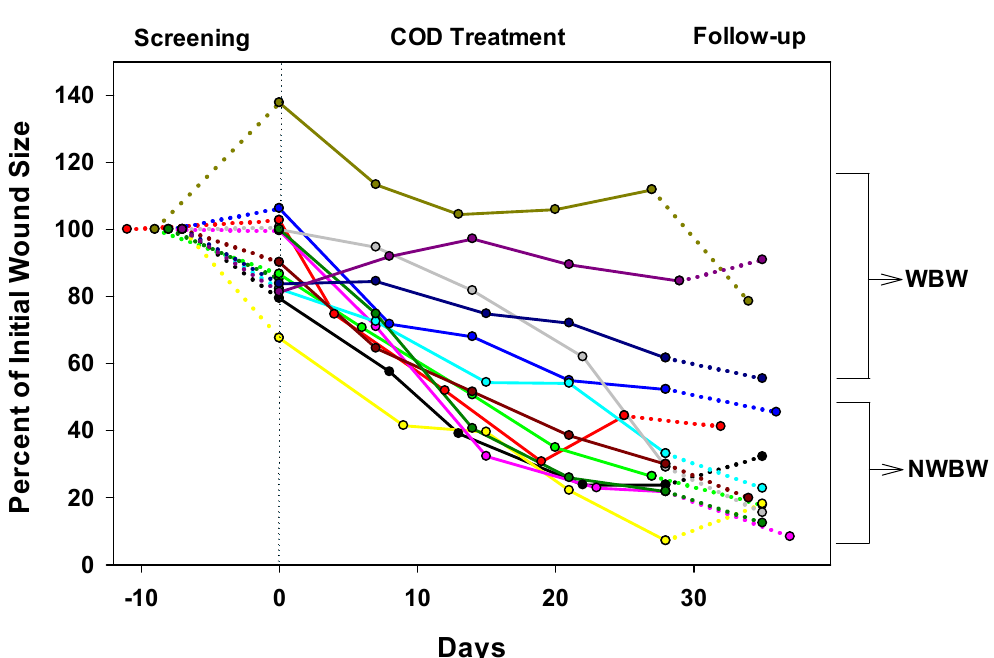
Figure 5. The sizes of the wounds normalized to the initial wound size per wound healing day for all 13 patients are shown. Day 0 represents the day the COD treatment started. Each color represents a different patient. The continuous line represents the Treatment Phase, which is preceded by the Screening Phase (dotted lines) and followed by the Follow-up Phase (dotted lines). The three upper lines belong to the three patients with weight-bearing wounds (WBW) and the other 10 lines belong to the 10 patients with non-weight-bearing wounds (NWBW). Each circle represents the date when the wound dressing was changed in the clinic and the wound size was measured by the wound imaging artificial intelligence system.